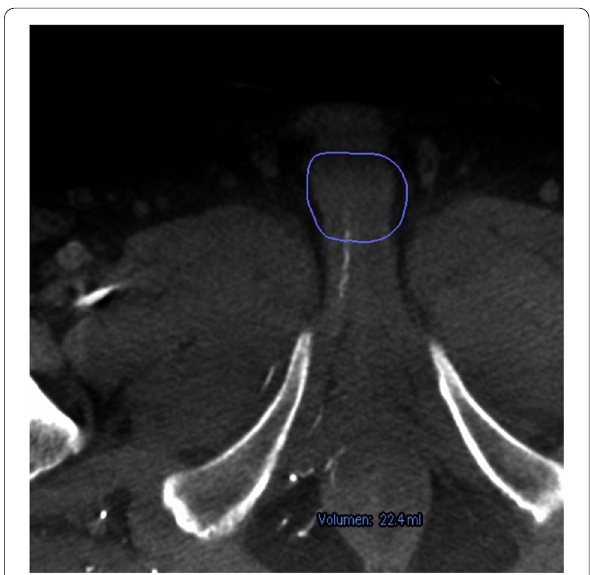
Fig. 1 After performing a cone-beam computed tomography (CBCT) the EmboGuide ® software (Philips) is used to calculate a road map. As a first step the root of the penis is marked as navigation target (blue circle). Shown are the images of a 63-year-old patient with arteriogenic erectile